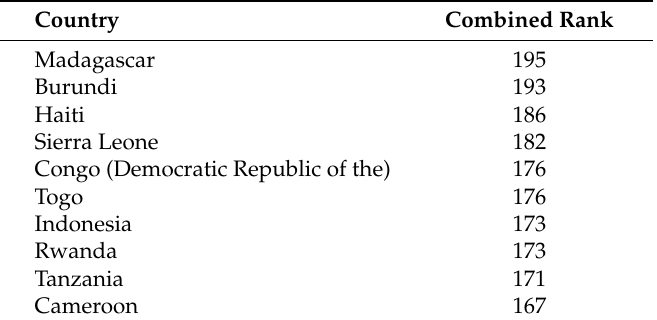
Table 1. Top 10 countries with highest combined rank (shown in red on Figure 2).